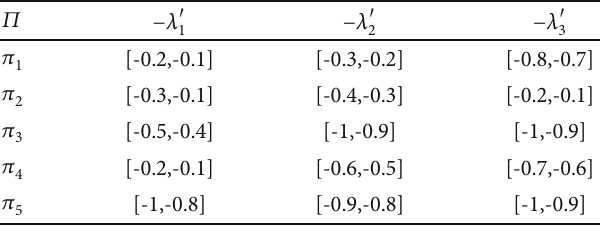
Table 11: The fi rst negative pole membership intervals.